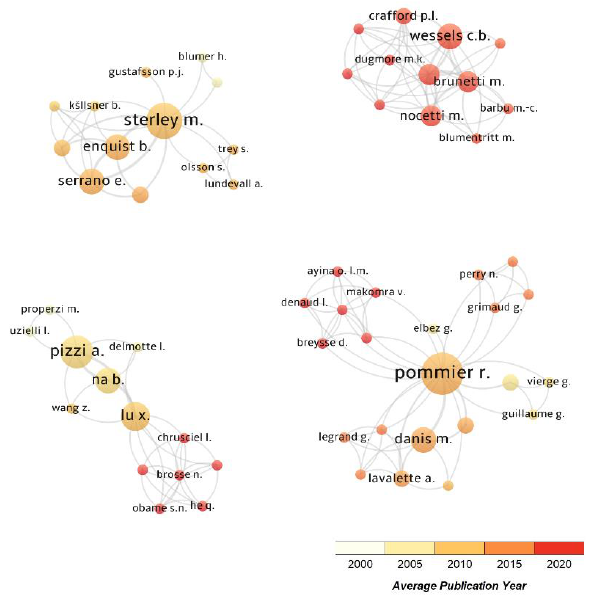
Figure 4. Co-author network of leading researchers in “Green Glued”, in overlay visualization (VOSviewer). The timeline accounts for the average publication year of each author through a color scale from 2000 to 2020, where 2020 is represented with the most intense color (red).